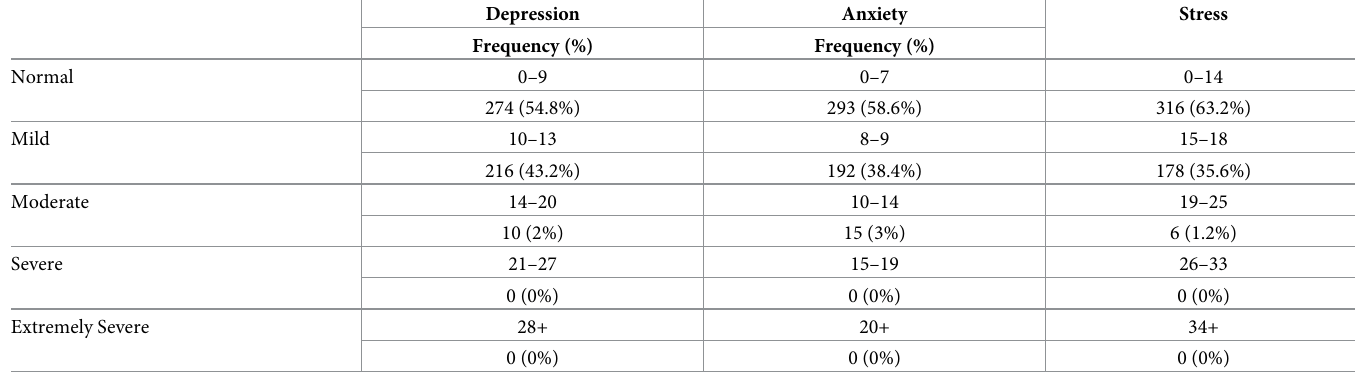
Table 3. Criterion scores and summary of participants for DASS levels of severity of depression, anxiety, and